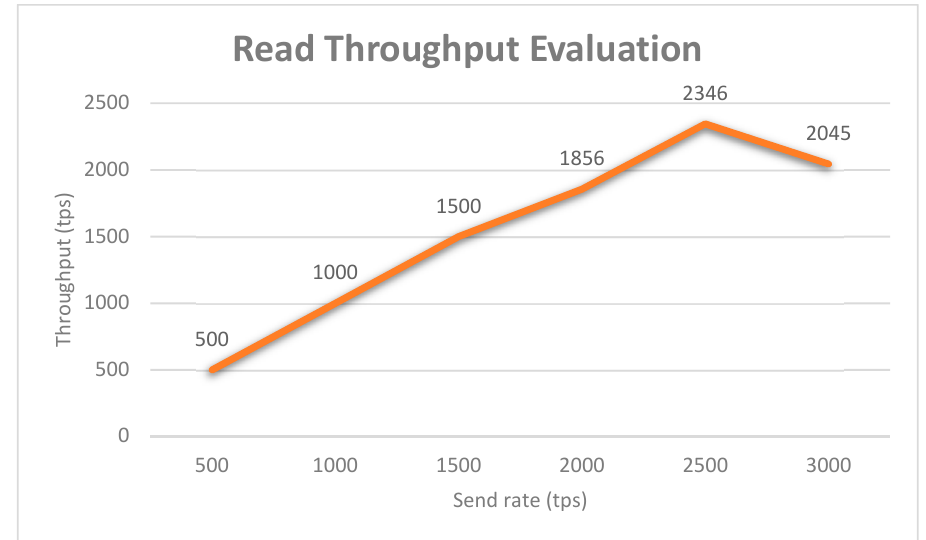
Figure 20. Blockchain network read throughput evaluation.